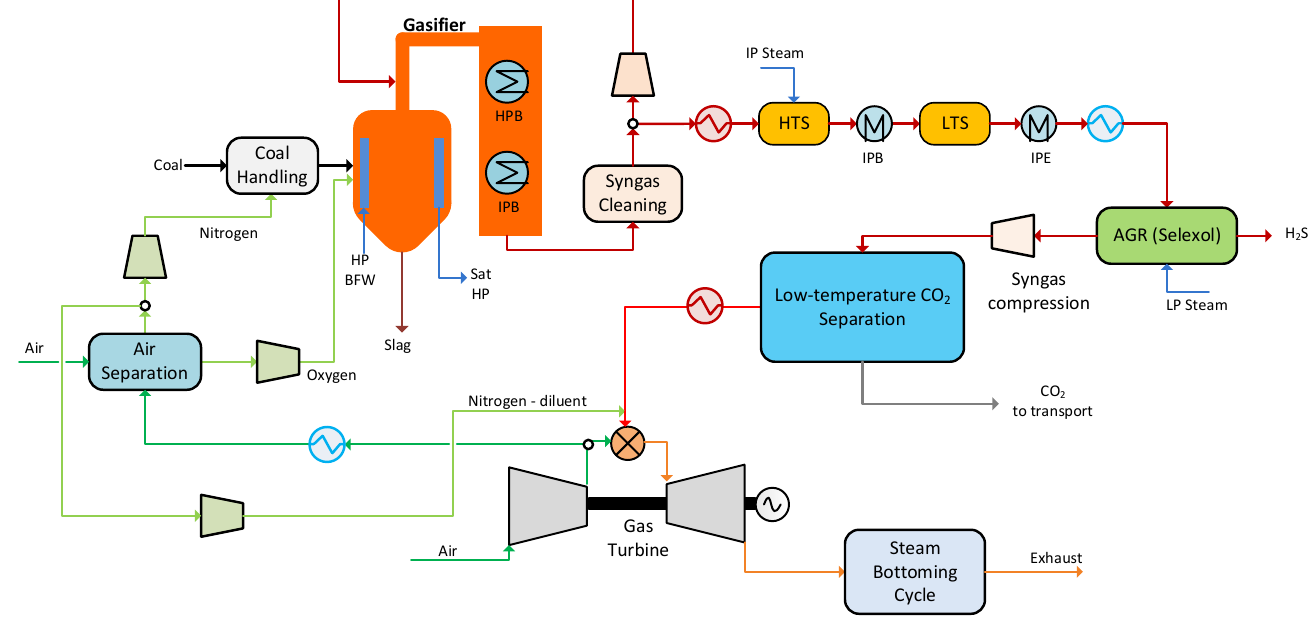
Figure 1. Block diagram of the integrated gasification combined cycle with low-temperature CO 2 capture.